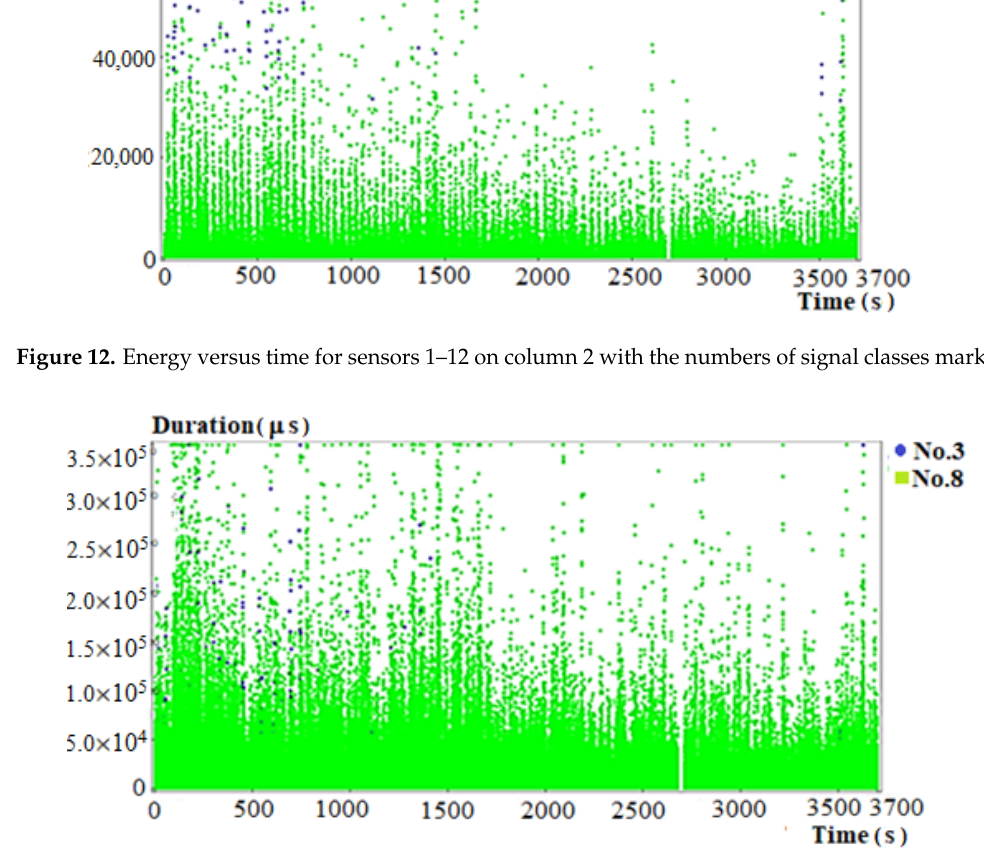
Figure 13. Acoustic emission (AE) signal duration versus time for sensors 1–2 on column 2 with the numbers of signal classes marked.